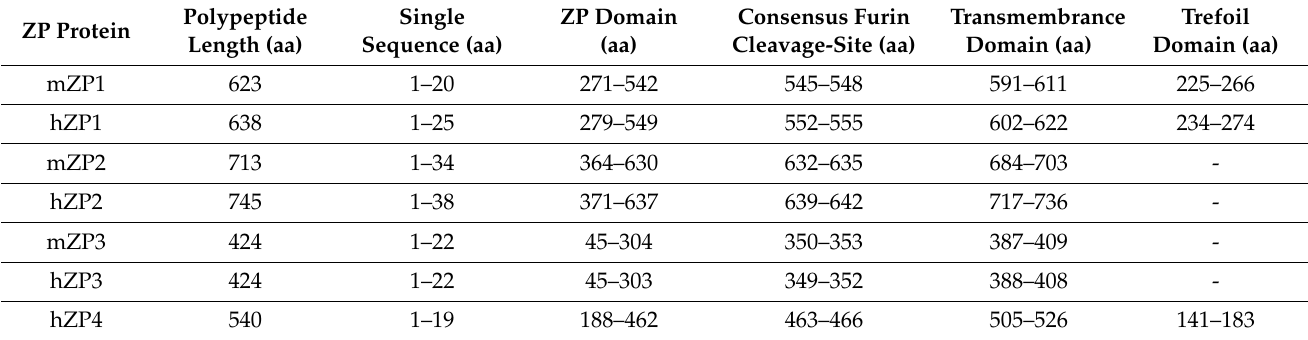
Table 2. Peimary Structure of Mouse (m) and Human (h) ZP